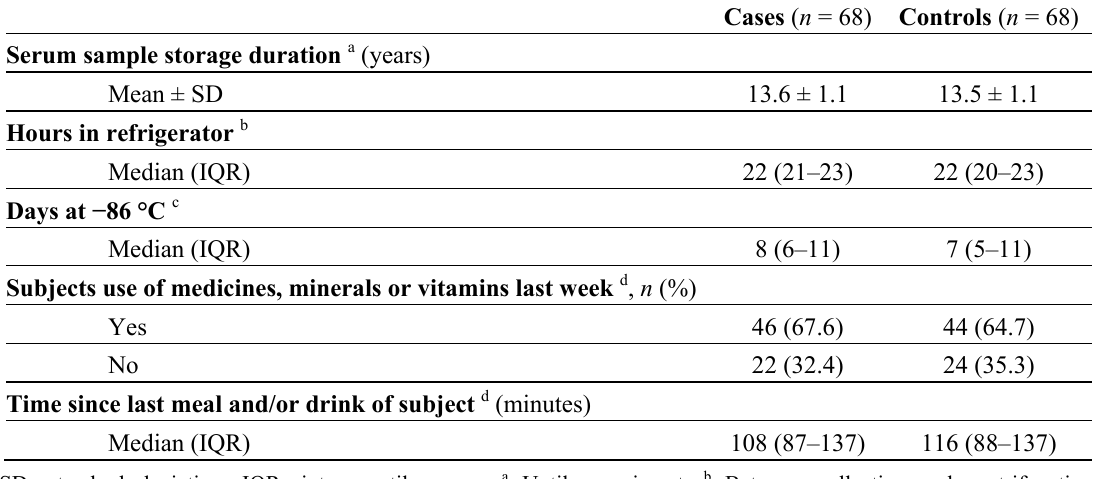
Table 3. Characteristics of the serum